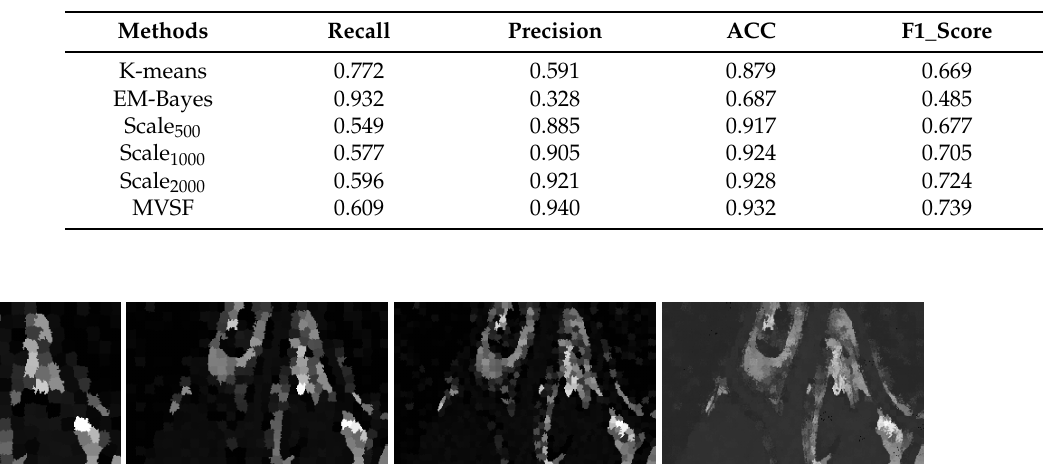
Table 5. Quantitative evaluation of CD results by different methods for Exp.1.